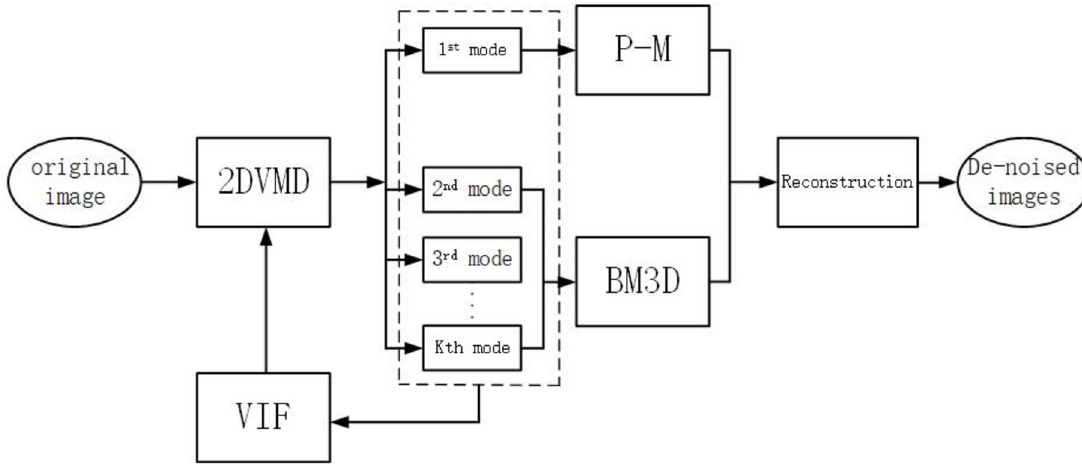
Fig 2. Flow chart of the proposed